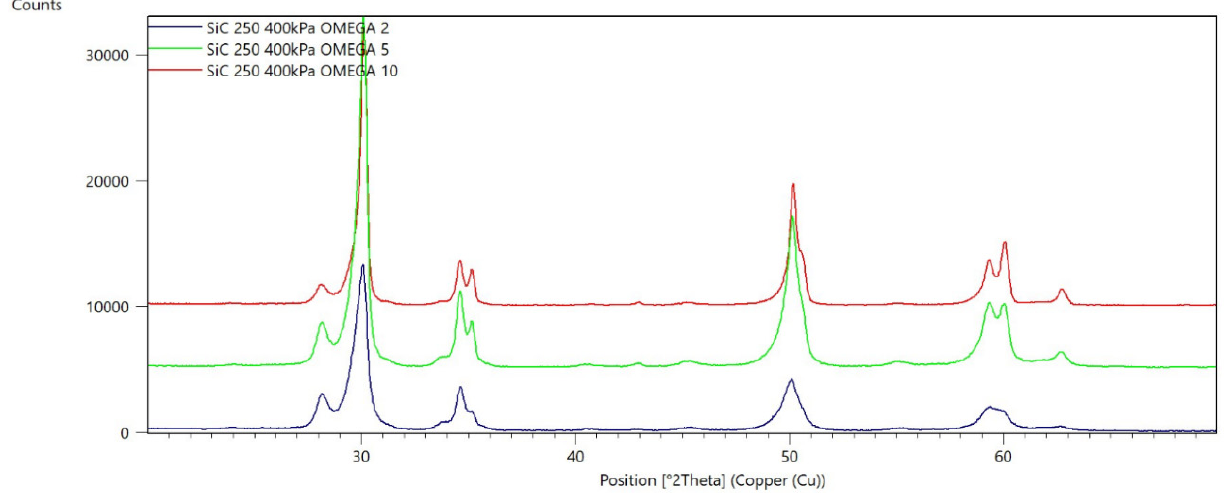
Figure 13. Diffraction patterns of sample L (abrasive—SiC 250 μ m, pressure 400 kPa).